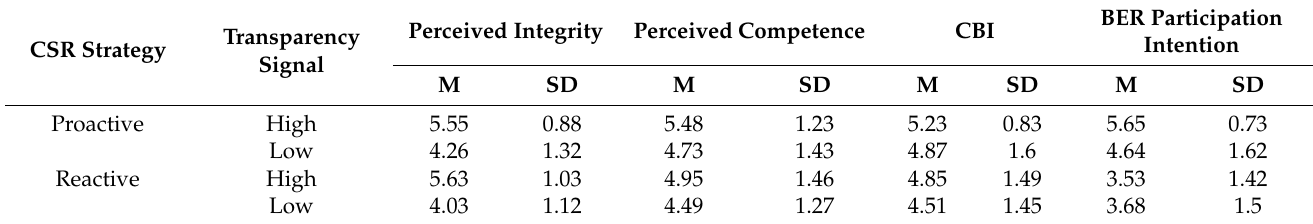
Table 3. Means and standard deviations for dependent variables.